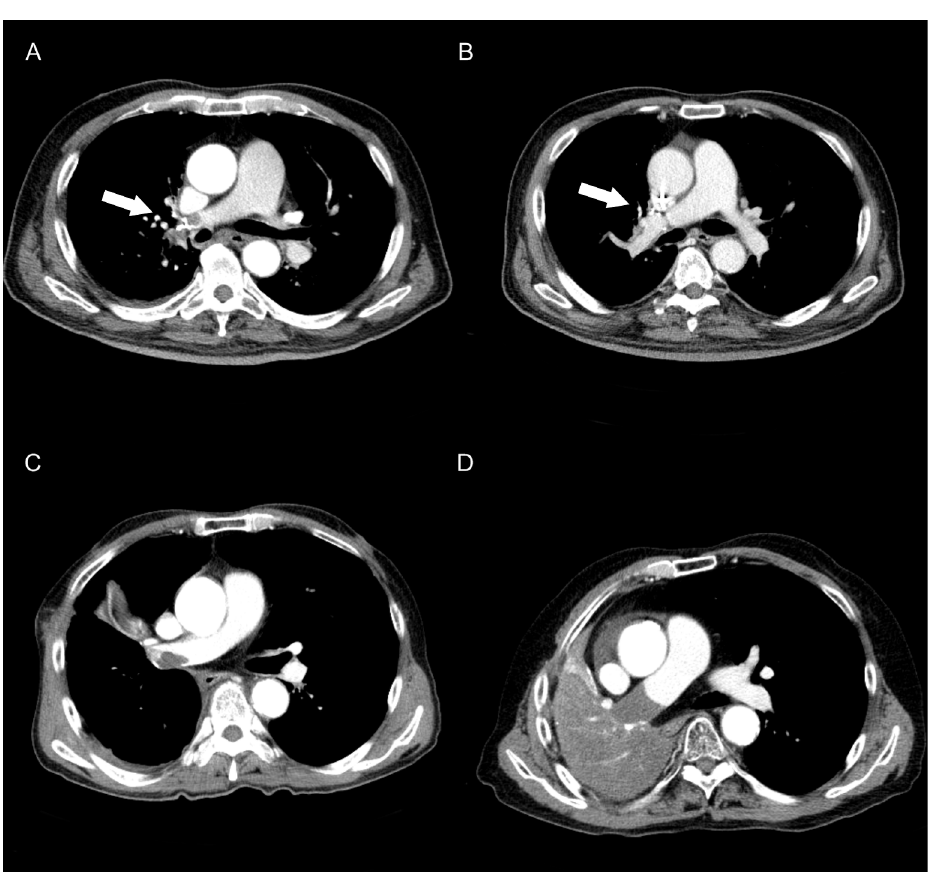
Fig 2. Various courses of vascularstump thrombi on follow-up CT scans. (A) A 77-year-old female status post VATS RUL lobectomydevelopedpulmonary arterial vascular stump thrombi on the first follow-up CT scan (26 days after surgery). (B) At the second follow-upCT scan, the thrombus had resolved spontaneously (the white arrow indicatesthe vascular stump). (C) A 72-year-old female status post right middleand lower lobe bilobectomy developeda pulmonary arterial vascular stump thrombus, which was detected 22 days after surgery. (D) The pulmonary arterial stump thrombus first shown as C had grown to completelyobstruct the right main pulmonary